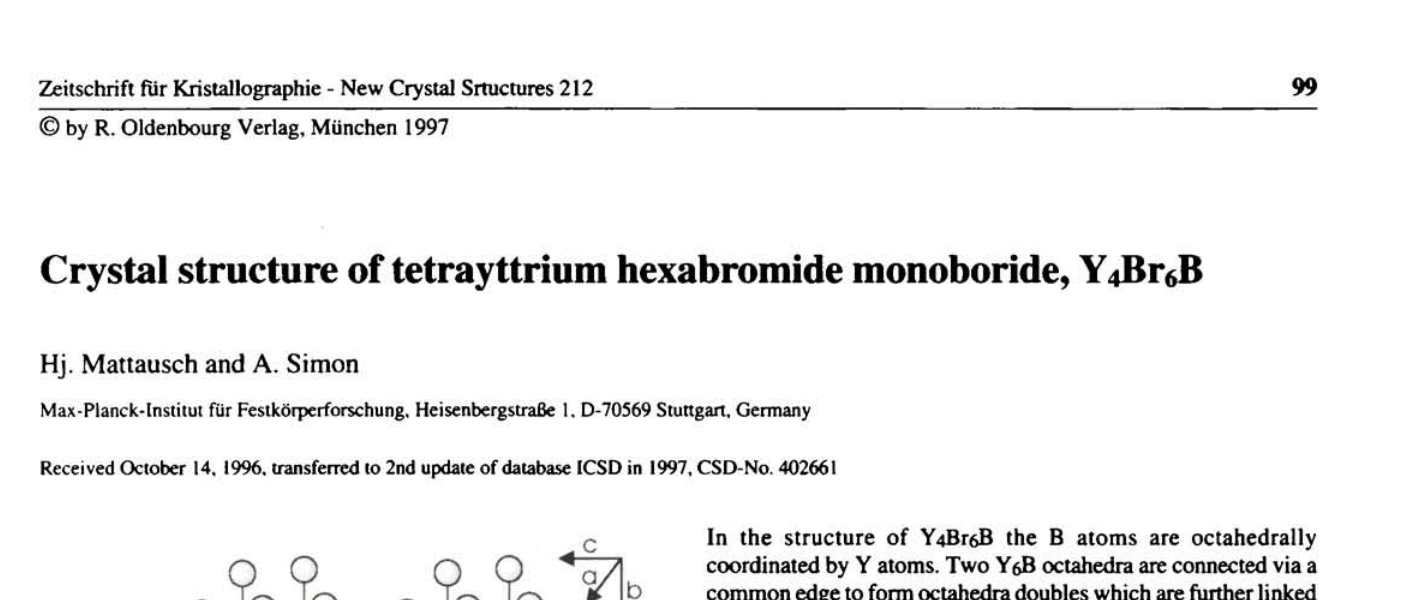
Table 1. Parameters used for the X-ray data collection Crystal: